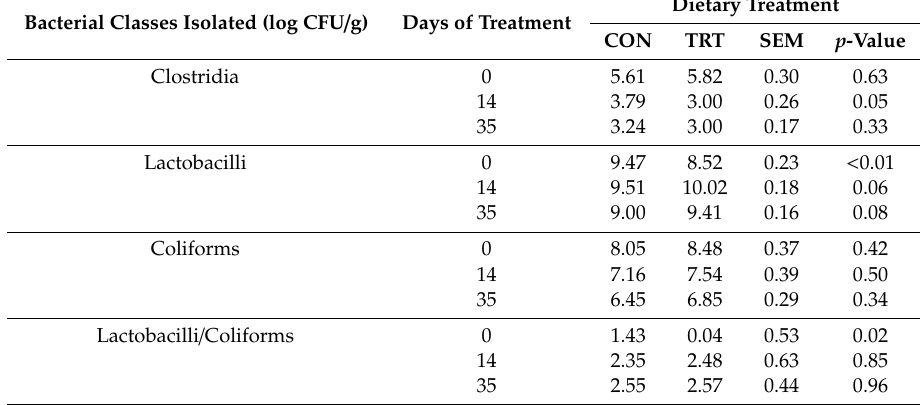
Table 3. Faecal bacterial counts of postweaning piglets supplemented with mannan oligosaccharides. Data shown as LSMeans ± SEM. Bacterial Classes Isolated (log CFU / g) Days of Treatment